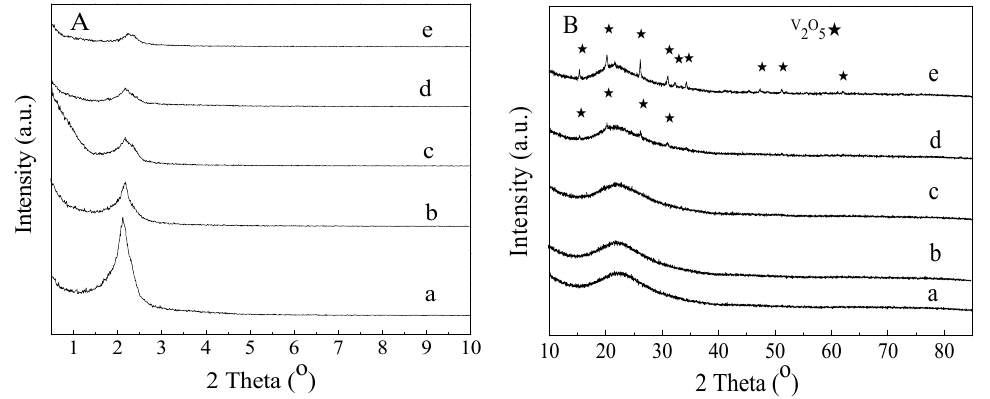
(o ) 2 Theta Figure 1. X ‐ ray diffraction (XRD) patterns of MSU ‐ 1 and VO x /MSU ‐ 1 with different VO x loading. Figure 1. X-ray diffraction (XRD) patterns of MSU-1 and VO x /MSU-1 with different VO x loading. ( A ) 2 θ in the range of 0.5°–10°; ( B ) 2 θ in the range of 10°–85°. ( a ) MSU ‐ 1; ( b ) 2.5 wt. % VO x /MSU ‐ 1; ( A ) 2 θ in the range of 0.5 ˝ –10 ˝ ; ( B ) 2 θ in the range of 10 ˝ –85 ˝ . ( a ) MSU-1; ( b ) 2.5 wt. % VO x /MSU-1; ( c ) 7.0 wt. % VO x /MSU ‐ 1; ( d ) 12.0 wt. % VO x /MSU ‐ 1; and ( e ) 17.5 wt. % VO x /MSU ‐ 1. ( c ) 7.0 wt. % VO x /MSU-1; ( d ) 12.0 wt. % VO x /MSU-1; and ( e ) 17.5 wt. % VO x /MSU-1.